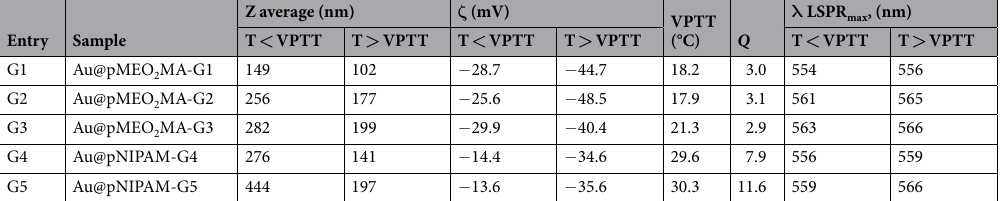
Table 2. Z Average Diameter and Zeta Potential ( ζ ) at Temperature Below and Above the VPTT by DLS, Volume Temperature induced Phase Transition (VPTT), Swelling Ratio ( Q ) and Surface Plasmon Band Wavelength ( λ LSPR max ) of Au@polymer Hybrid Thermoresponsive Nanogels at Temperature Below and Above the